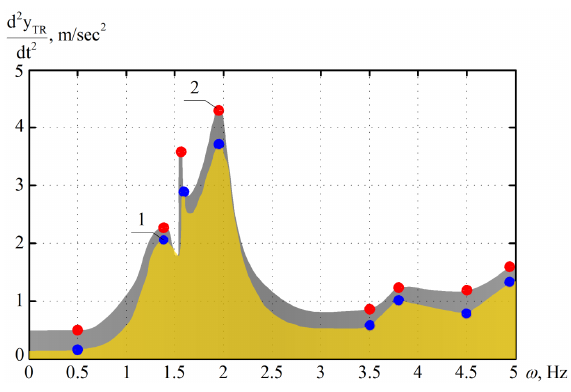
Fig. 2. Amplitude-frequency characteristics of vertical accelerations tractor frame: 1 – liquid cargo; 2 – solid cargo The following variations of the impact of resonant zones are observed during an exploration of the seat accelerations change ( Fig. 3 ) in the low frequency range: – the front tractor axle by 8.5 %; – influence of semitrailer unit by 15.4 %; – tractor frame by 7.8 %.